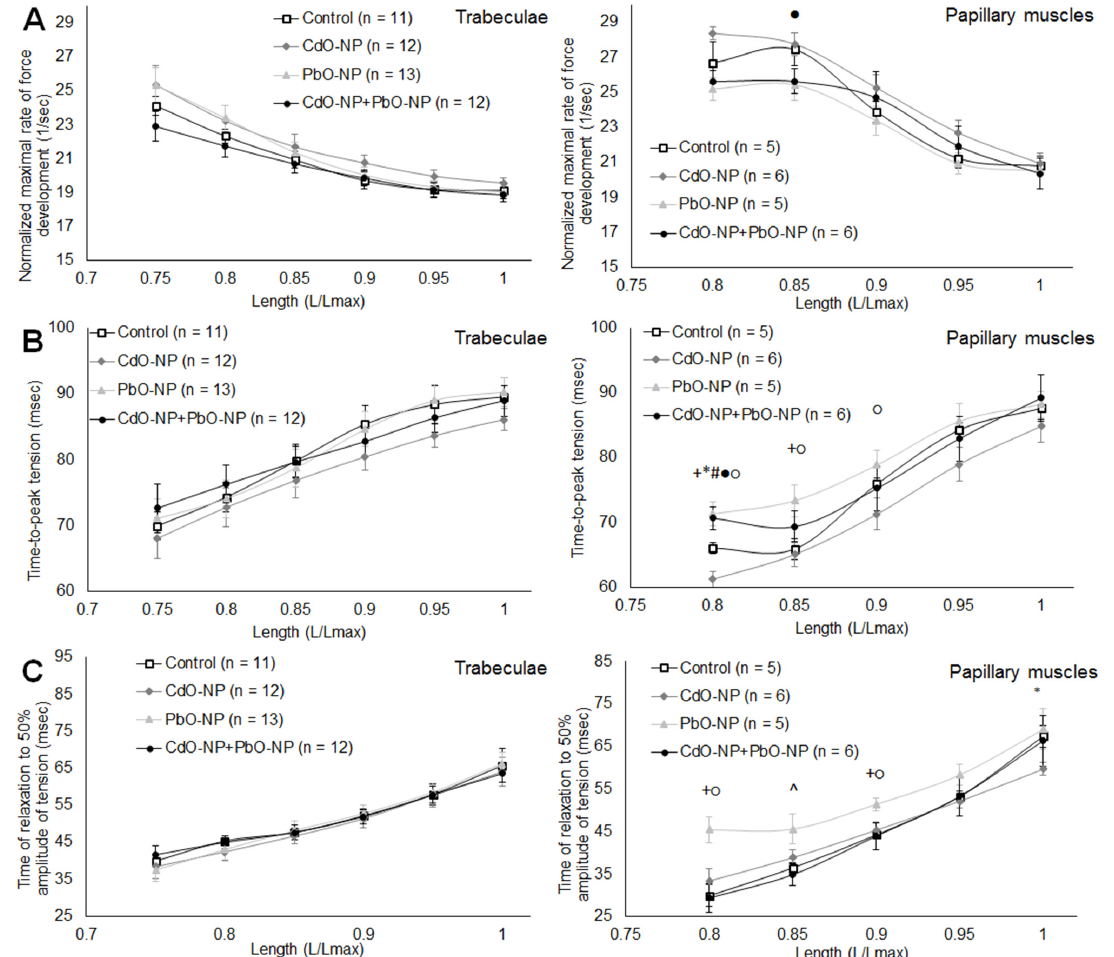
Figure 4. The relationships of the maximal normalized rate ( A ), time-to-peak of force development ( B ) and time of relaxation to 50% amplitude of tension ( C ) vs. relative muscle length, obtained for trabeculae (left panels) and papillary muscles (right panels). Muscle length is shown in L MAX units. Data are shown as mean ± S.E. There are significant differences: *—CdO–NP vs. Control, +—PbO–NP vs. Control, #—CdO–NP + PbO–NP vs. Control, ● —CdO–NP + PbO– NP vs. CdO–NP, ^—CdO–NP + PbO–NP vs. PbO–NP, ○ —PbO–NP vs. CdO–NP ( p < 0.05).